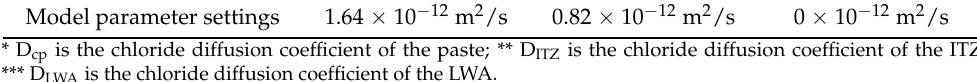
Table 8. Parameters related to chloride Table 7. Random aggregate model parameter settings.